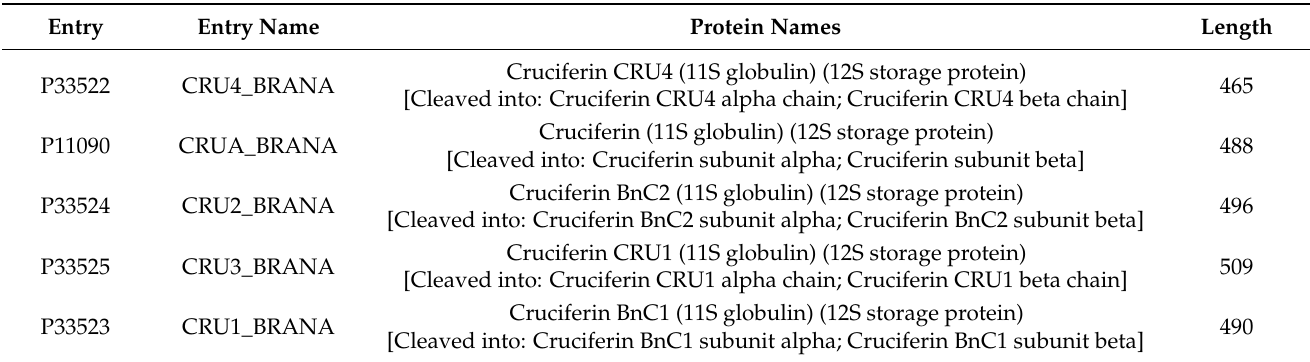
Table 4. Five manually curated entries for Brassica napus L. cruciferin are listed in the Uniprot database (Source: https: //www.uniprot.org, accessed September 2021). Length is presented as amino acid count.